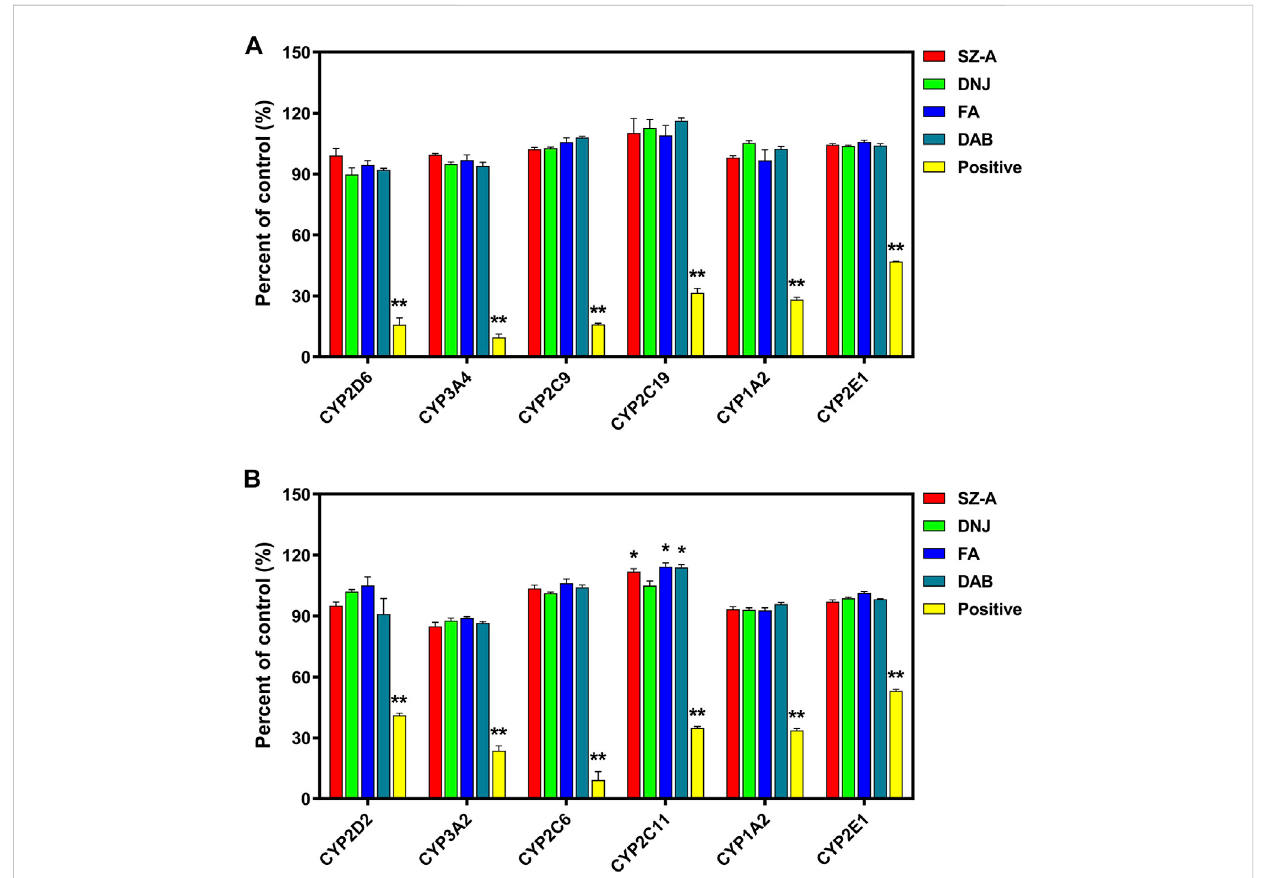
FIGURE 6 The effect of SZ-A on the activity of CYP450s in human liver microsomes (HLMs, (A) )and rat liver microsomes (RLMs, (B) ). Each valuerepresents the mean ± standard error of mean (SEM) ( n = 3). * p < 0.05, ** p < 0.01 compared with the control